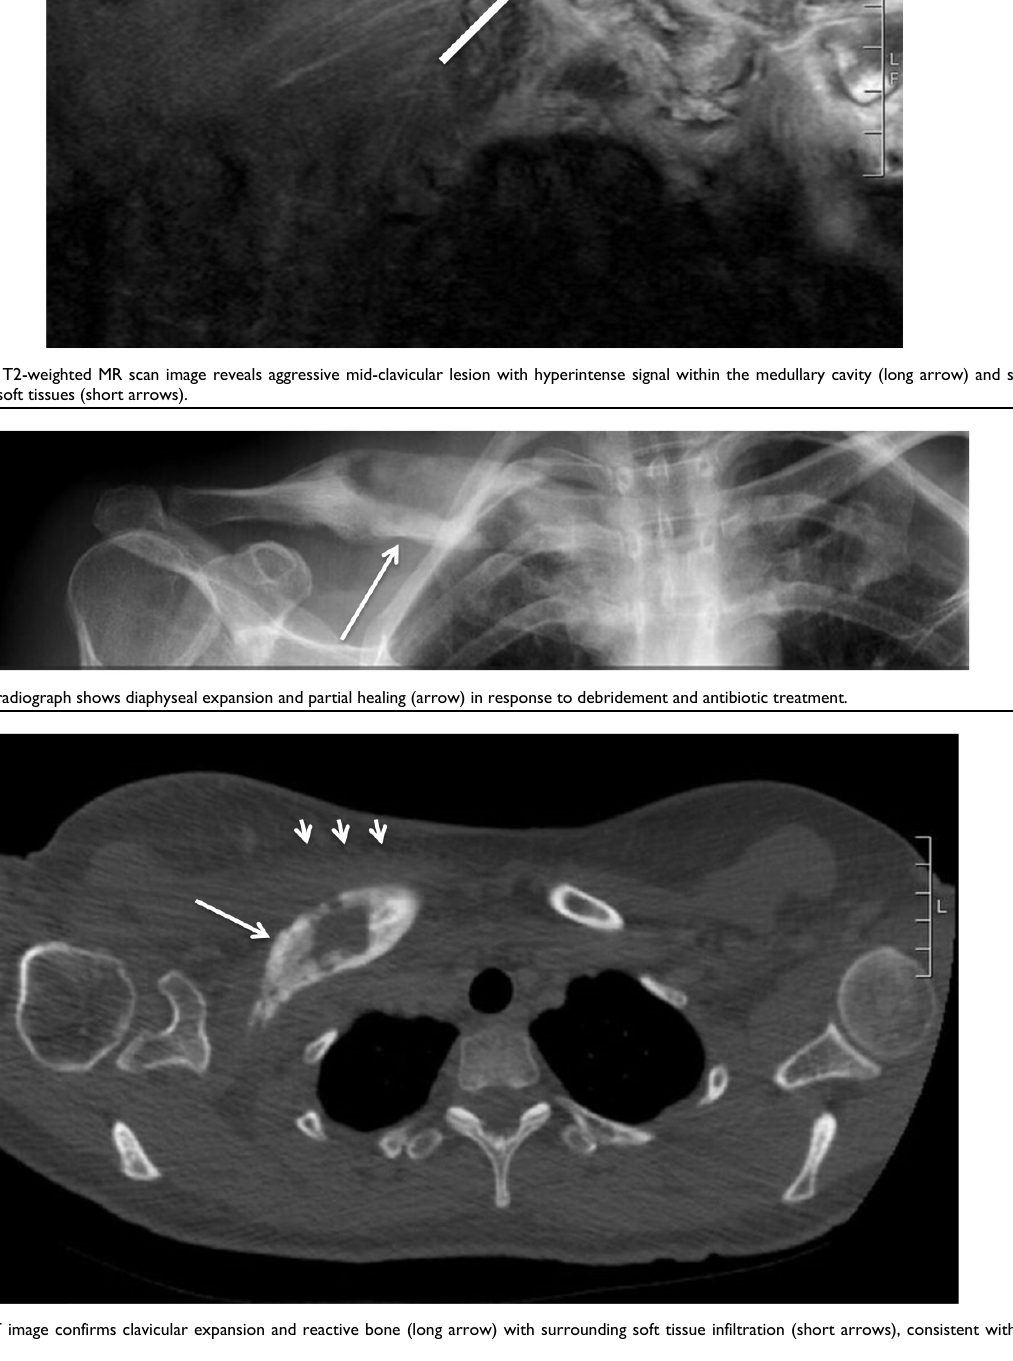
http://www.jbji.net